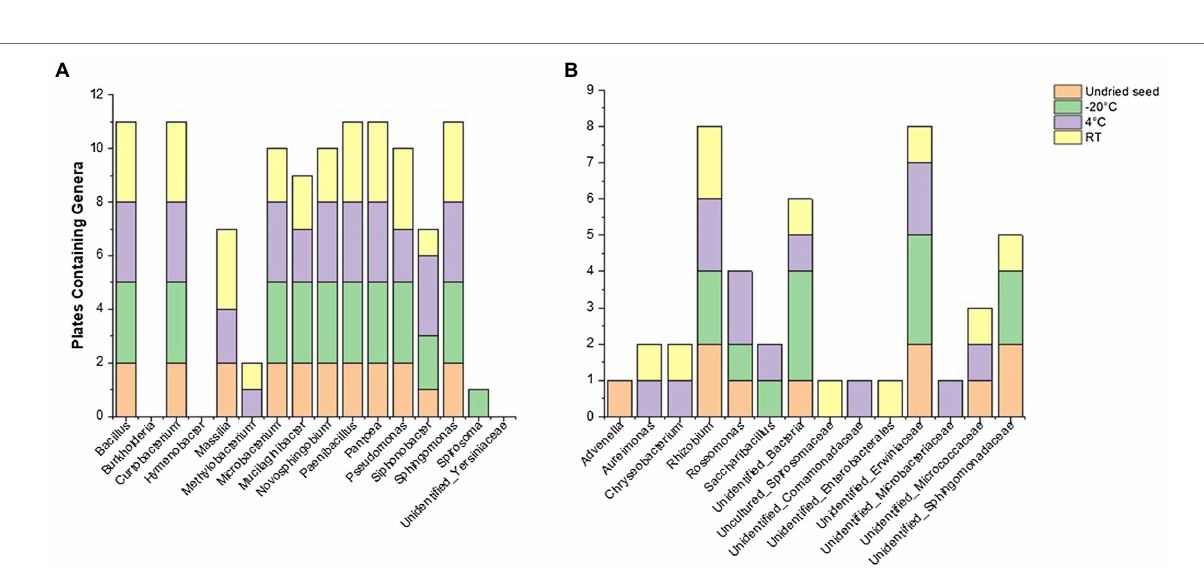
FIGURE 5 | Culturability of bacterial genera that were associated with undried seed ( in planta ) across different time points (0, 3, 6, and 14 months) when stored at − 20 ° C, 4 ° C, and room temperature (RT). (A) Genera with >0.1% relative abundance and (B) <0.1% relative abundance in undried seed ( in planta